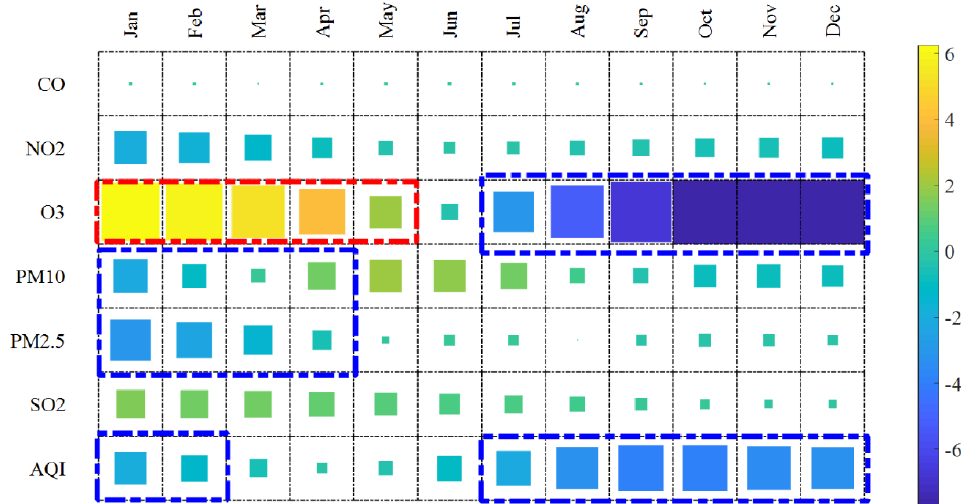
Figure 2. The trends in the mean values of the last IMF each month. (Note: The Y − axis indicates different pollutants, and the X − axis indicates the month. The square size represents the degree of change in air quality, and the larger the square size, the greater the degree. Blue and yellow represent the improvement and deterioration of air quality, respectively. The numbers corresponding to the colors also represent changes in air quality. A positive (negative) number indicates deterioration (improvement) in air quality. The smaller the number, the better the air quality improvement.)